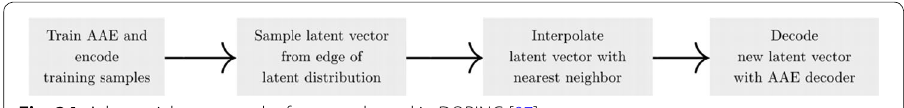
Fig. 24 Adversarial autoencoder framework used in DOPING